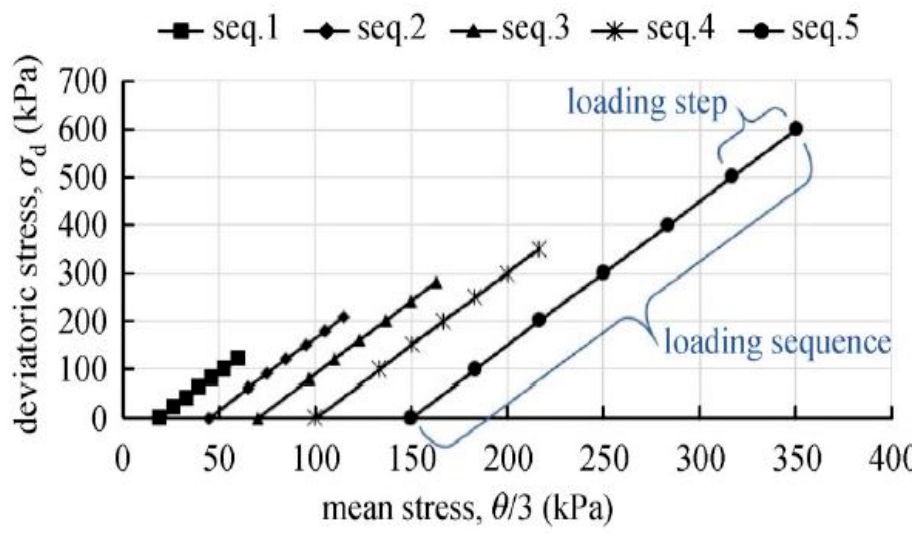
Figure 4. Loading sequence and load steps in a Multi-Stage Low-Stress level State (MS LSL), adapted from [39].